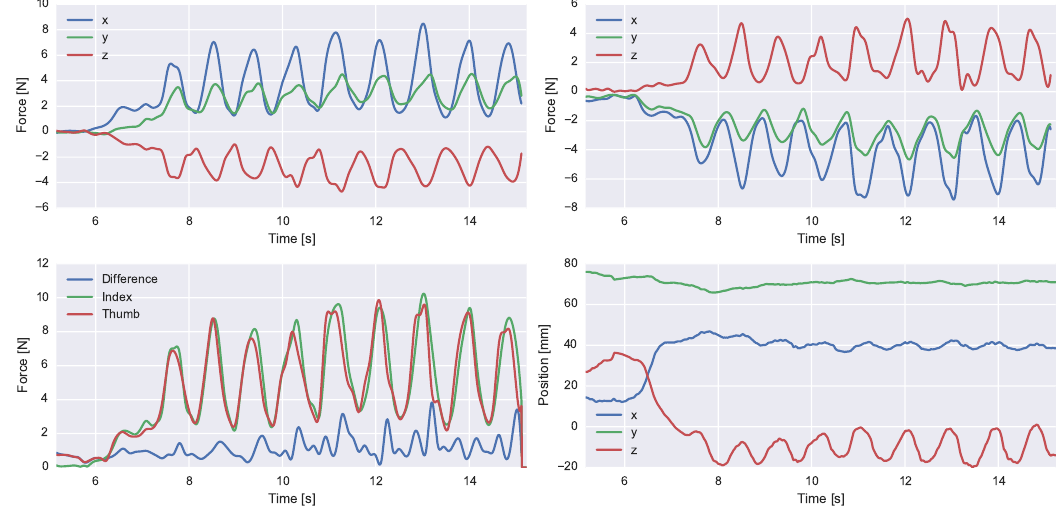
Figure 8. Example reconstruction of Experiment 2 where a spring load was manipulated. A force has been applied to the spring by index finger ( top left ) and thumb ( top right ). The magnitude of both index finger and thumb forces and the magnitude of the sum are depicted in the ( lower left ) graph. The ( lower right ) plot depicts the relative tip position. All signals are expressed in the global coordinate